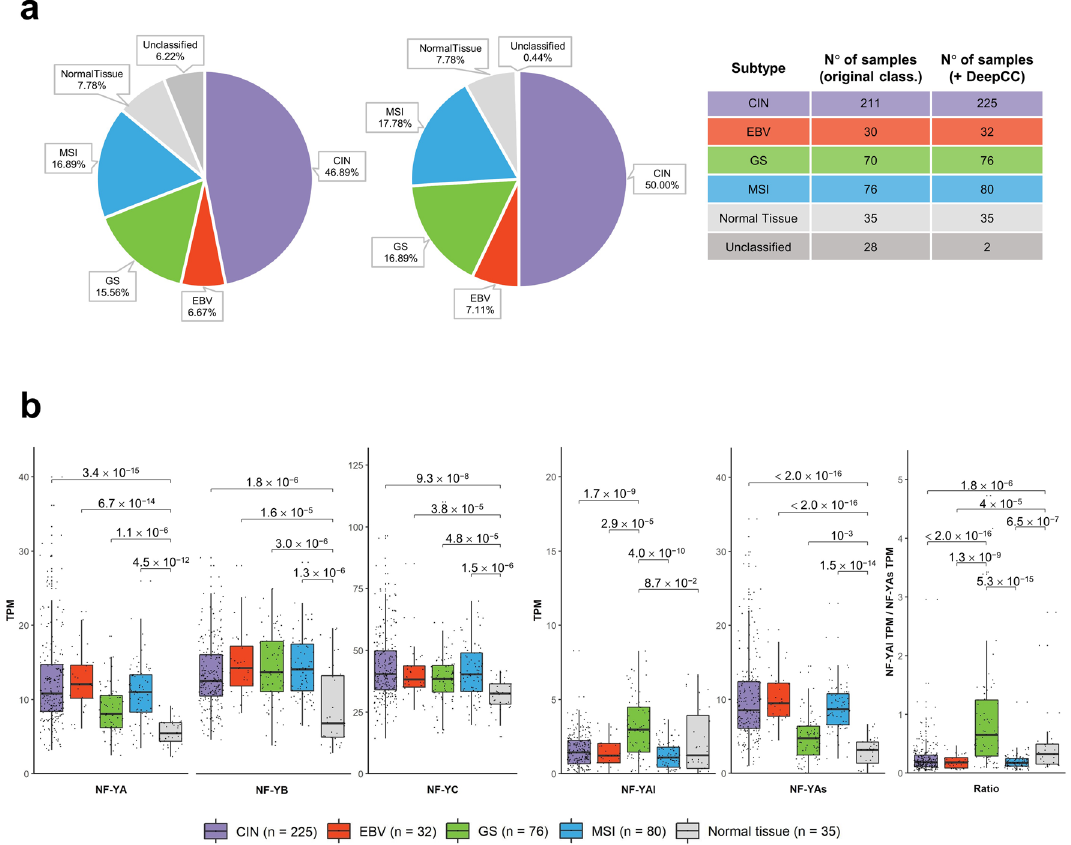
Figure 2. NF-Y levels in four subtypes of STAD (TCGA classification). ( a ) Classification of all TCGA samples for which there are RNA-seq data in the four subtypes. In the left pie the currently available samples (Unclassified 6.22%), in the right one our complete classification. The numbers for each subtype are in the scheme to the right. ( b ) Box plots of expression levels of the three NF-Y subunits at gene level (Left Panels), as well as of NF-YAl, NF-YAs and the NF-YAl/NF-YAs ratio (Right Panels), in the four subtypes of the TCGA STAD dataset as well as in normal tissues, measured in TPMs. p values are calculated using the Wilcoxon rank- sum